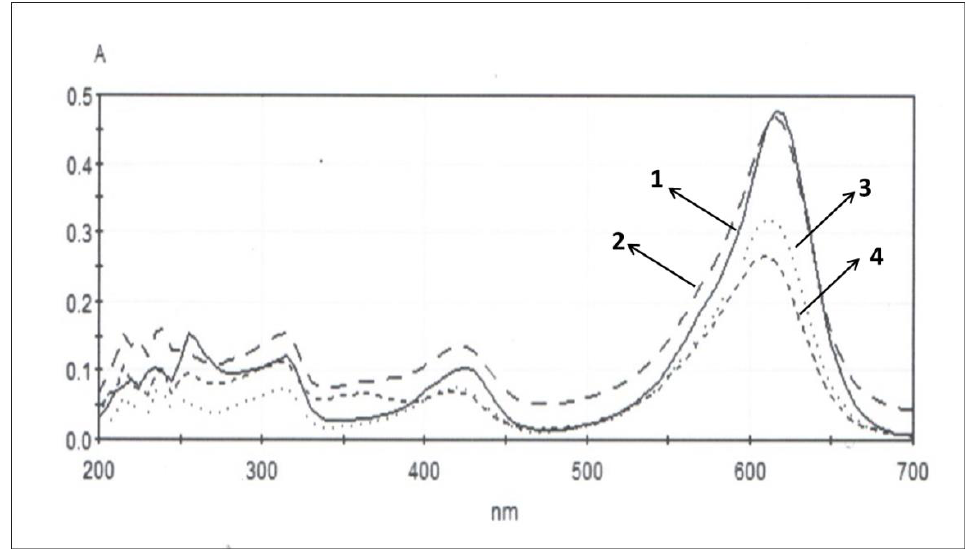
Figure 8. Change in the absorbance spectra of MG with the illumination time in the presence of synthesized by metal alkoxide TiO 2 after: 0 min ( 1 ); 60 min ( 2 ); 120 min ( 3 ); 180 min ( 4 ) of Vis irradiation.